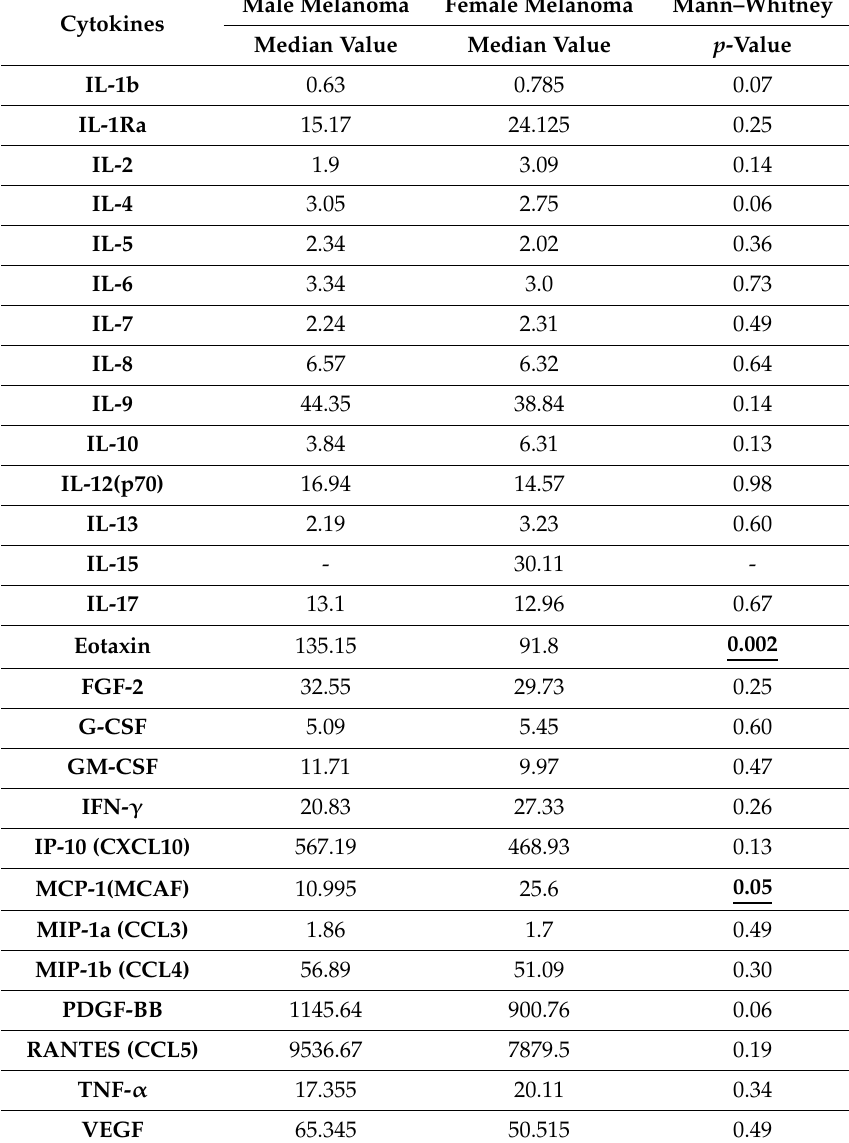
Table 6. Serum expression in male melanoma compared to female melanoma. For p -values < 0.05 (reported in bold and underlined), the null hypothesis (i.e., the two distributions have the same median) should be rejected. Briefly, the cytokine distributions for the control and melanoma patients with p -values < 0.05 have significantly di ff erent